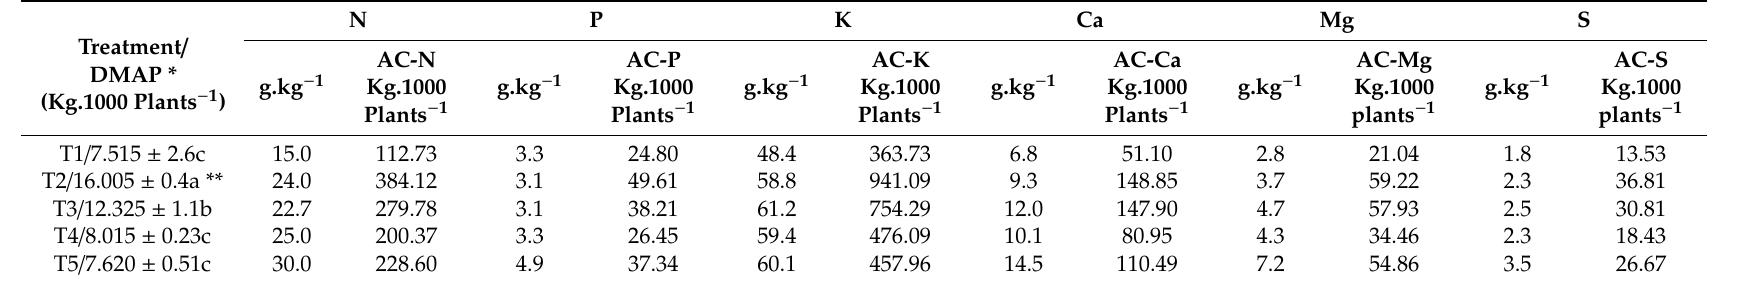
Table 5. Values of pepper leaf nutrient content (g.kg − 1 ). Accumulation (AC) in kg 1000 − 1 plants.